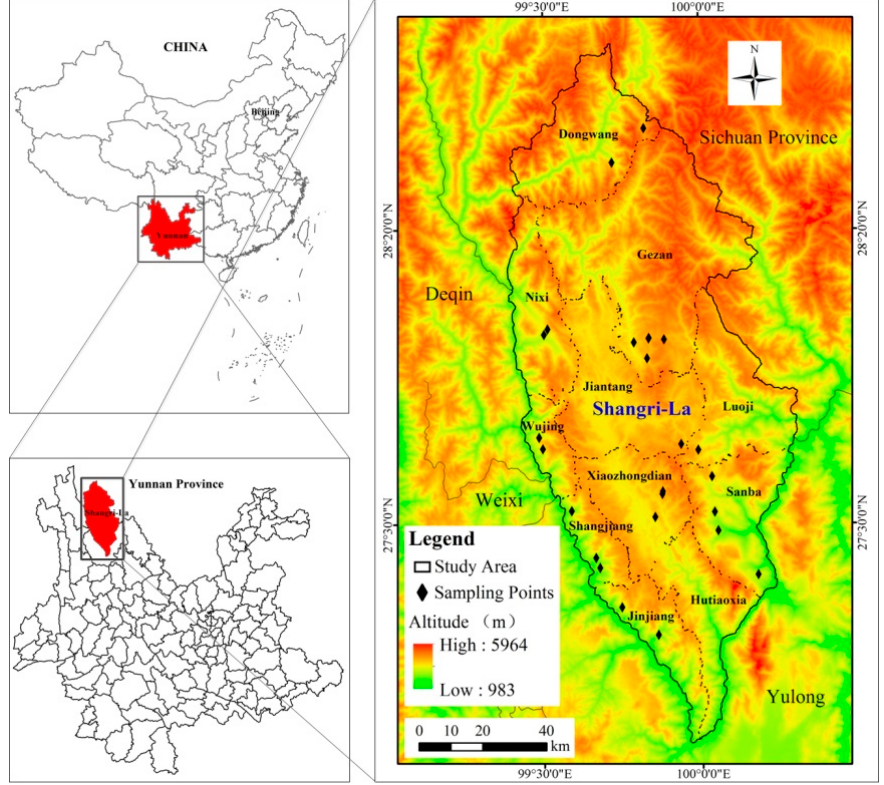
Figure 1. Position map of Shangri-La and distribution of sampling points in different stands.